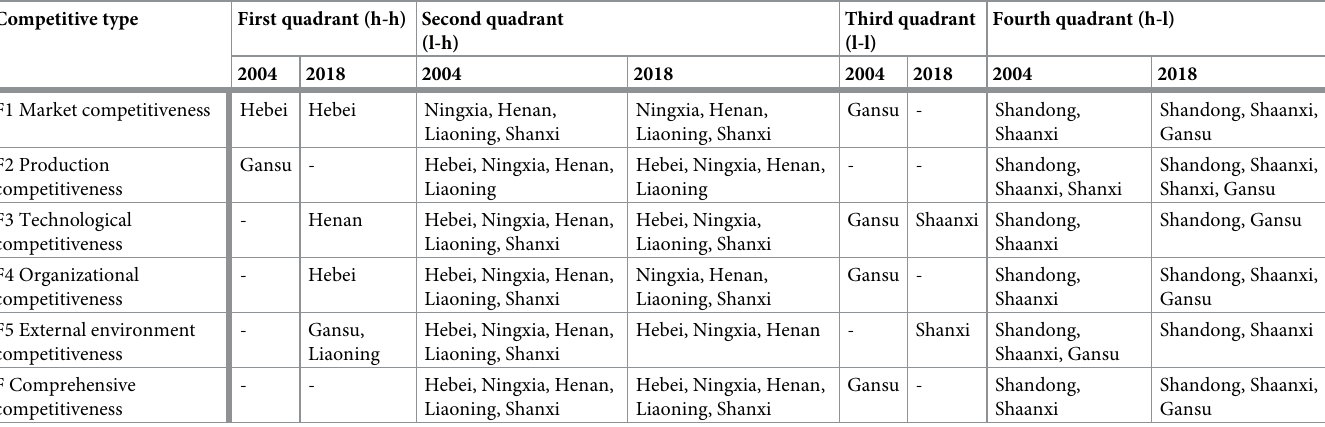
Table 5. Spatial correlation of competitiveness types in Chinal spatial dependence and no global spatial correlat8. Competitive